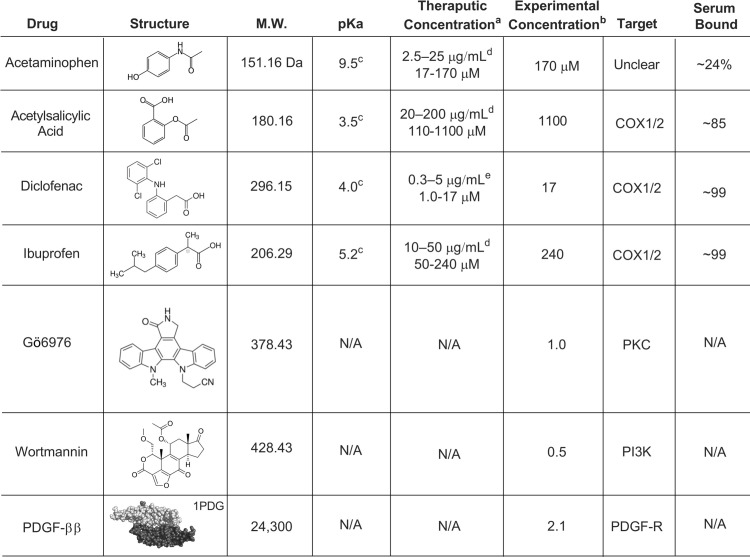
Drugs employed in the present study and key parameters.Shown are the four representative therapeutic drugs employed (acetylsalicylic acid, acetaminophen, diclofenac, ibuprofen) as well as the three control drugs (Gö6976, wortmannin, PDGF ββ). Information provided for each drug includes: chemical structure, molecular weight, pKa, therapeutic peak total concentration in human plasma following clinical dosage, total concentration employed in the present cultured cell experiments, target (where known), and percent bound to proteins in human plasma. Notes: arecommended therapeutic range of total drug concentration in human plasma; bexperimental total drug concentration in cell culture medium (this study); creferences [73, 74]; dreferences [57, 59]; ereference [58]; freferences [75–78].